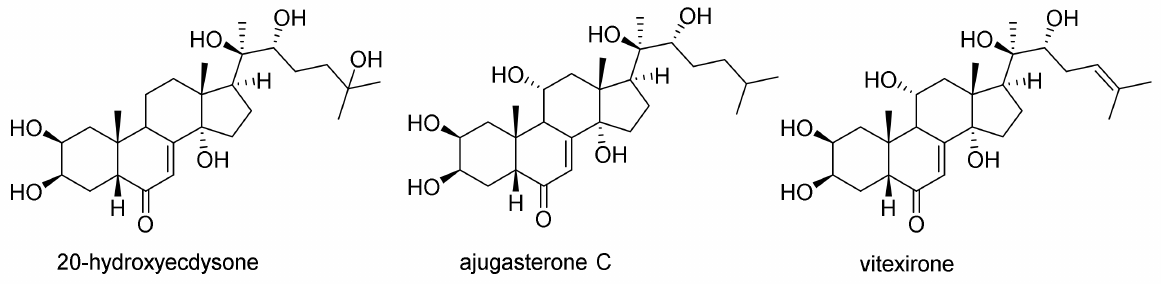
Figure 2. Structures of some ecdysteroids identified in V. madiensis